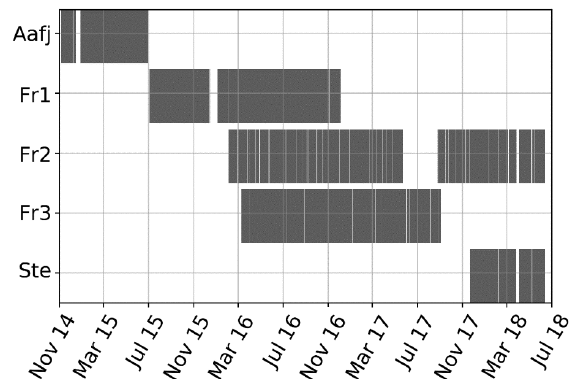
Fig. 2. Deployment and active periods for the ADCPs from 2014 to 2018. From deployment to recovery, the temporal coverage was 94% at Aafj (with hours sampled, n = 5332), 96% at Fr1 (n = 11969), 86% at Fr2 (n = 17675), 99% at Fr3 (n = 13019) and 95% at Ste (n = 4612). See Fig. 1 for site